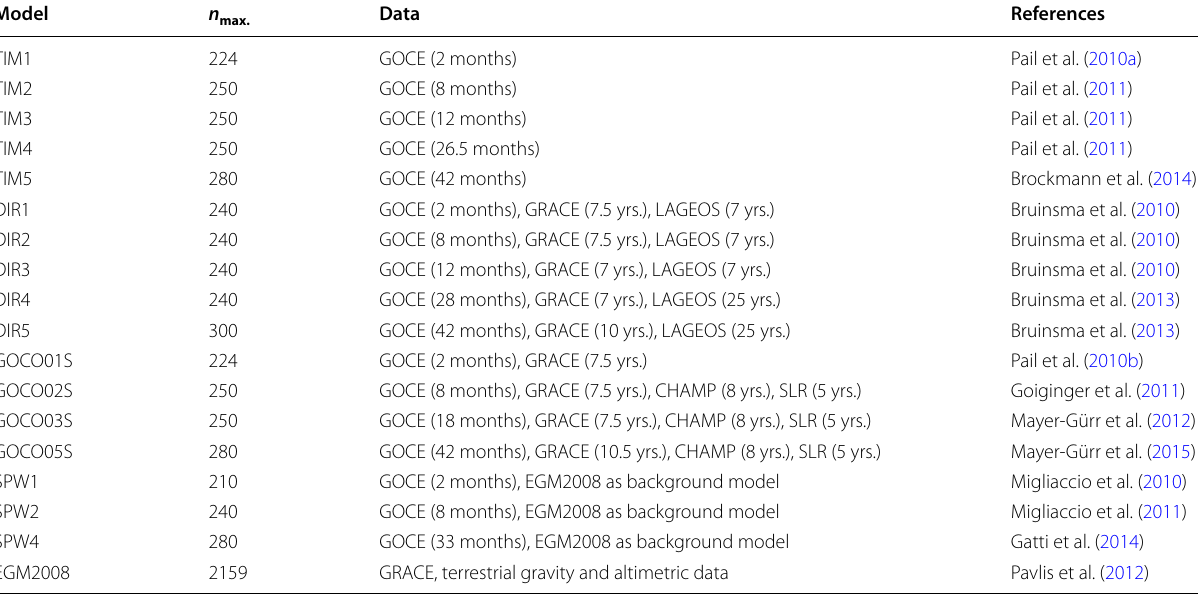
EGM2008 is also included